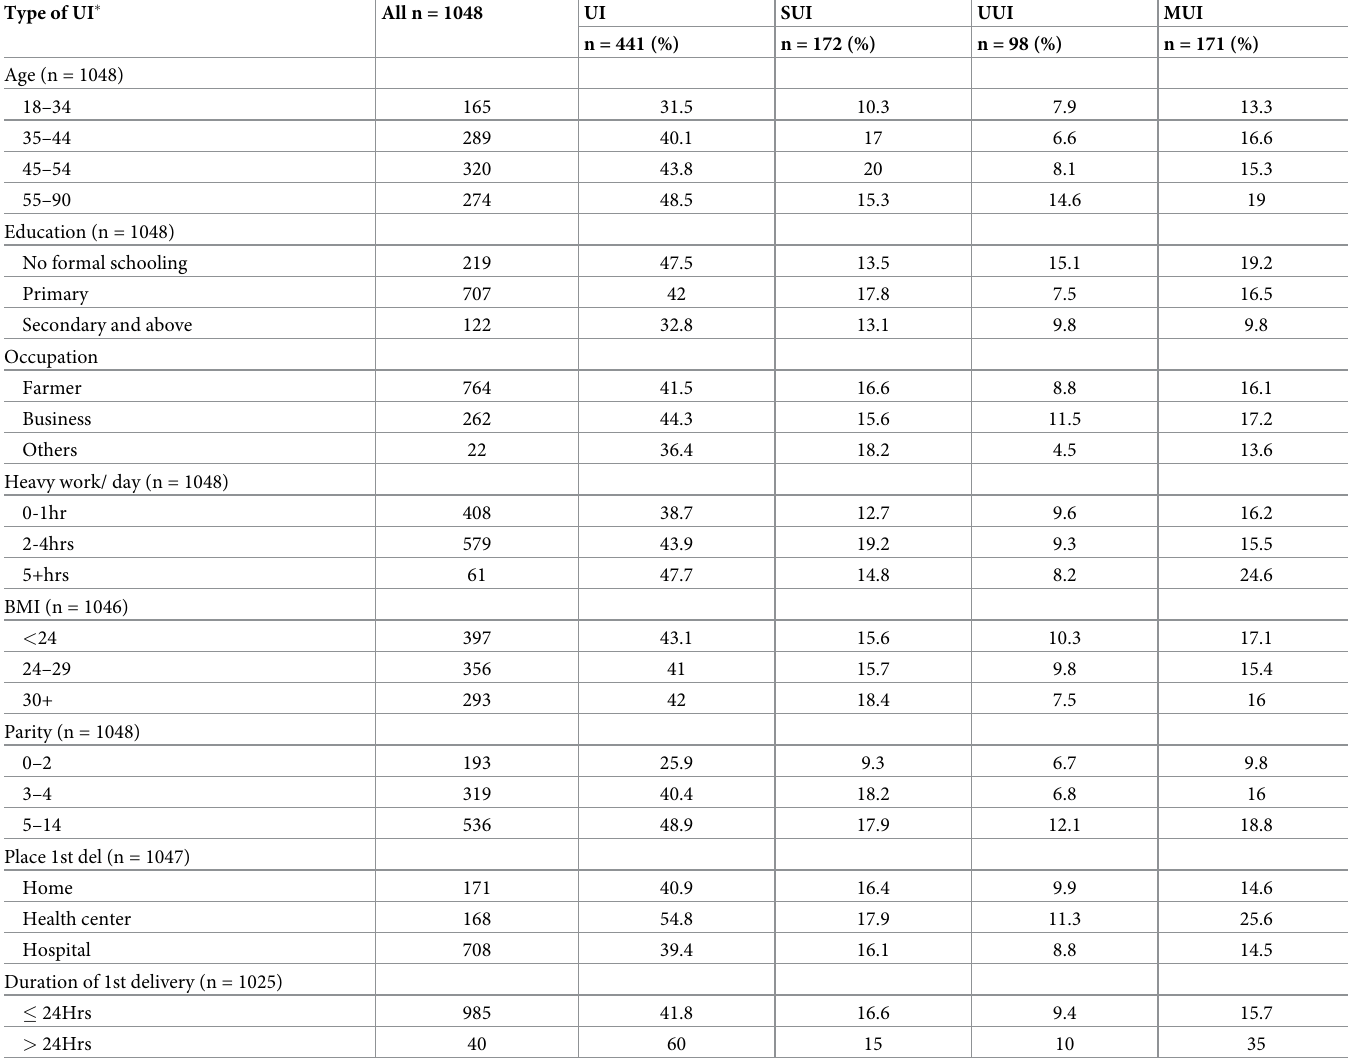
Table 1. Background characteristics of the study population and type of urinary